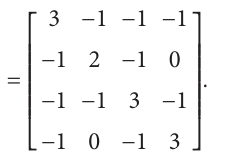
line, dashed line, dash-dotted line, and dotted line stand